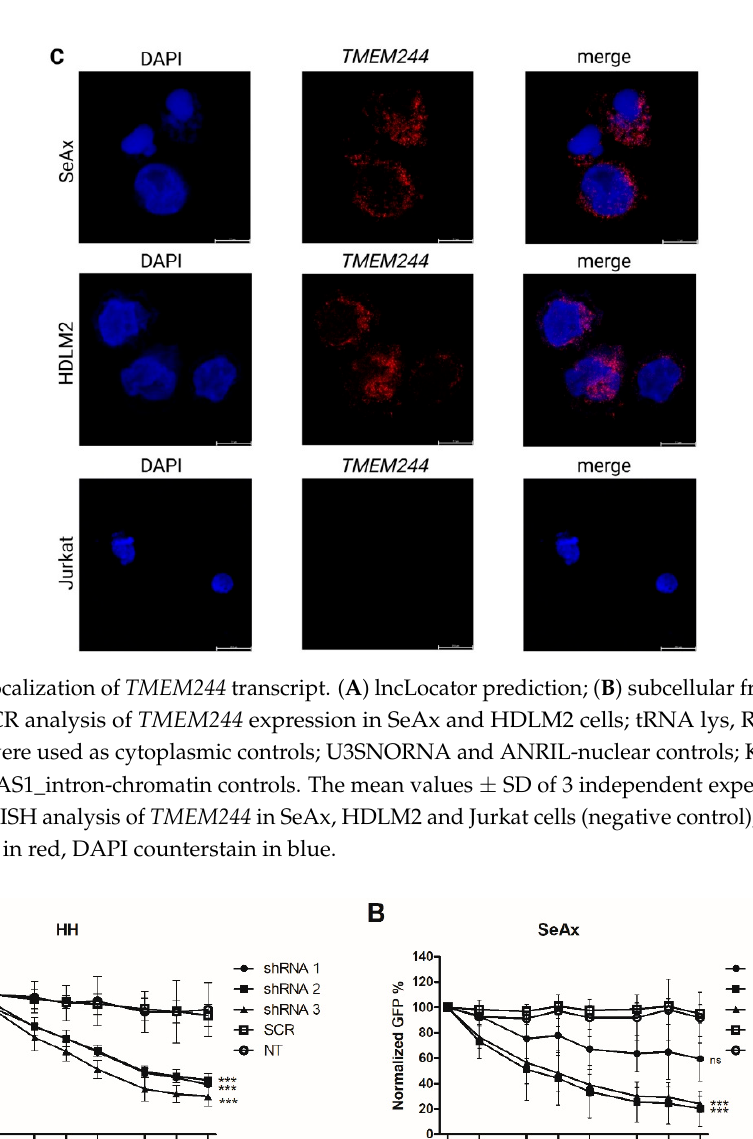
Figure 2. Localization of TMEM244 transcript. ( A ) lncLocator prediction; ( B ) subcellular fractiona ‐ tion and RT ‐ qPCR analysis of TMEM244 expression in SeAx and HDLM2 cells; tRNA lys, RPPH1, and DANCER were used as cytoplasmic controls; U3SNORNA and ANRIL ‐ nuclear controls; KTN1_AS1_ and KTN1_AS1_intron ‐ chromatin controls. The mean values ± SD of 3 independent experiments are shown ( C ) FISH analysis of TMEM244 in SeAx, HDLM2 and Jurkat cells (negative control); TMEM244 FISH signal in red, DAPI counterstain in blue.